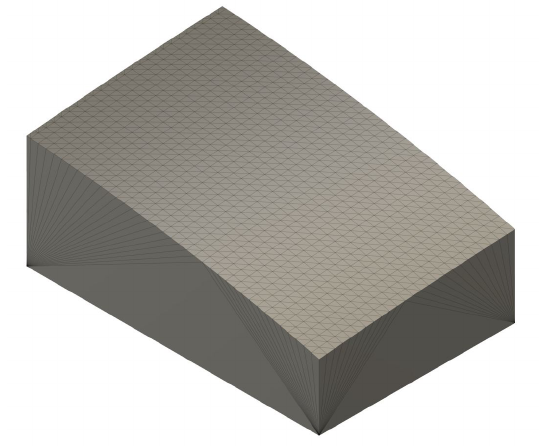
Figure 2. CAD model with 12.7 mm base